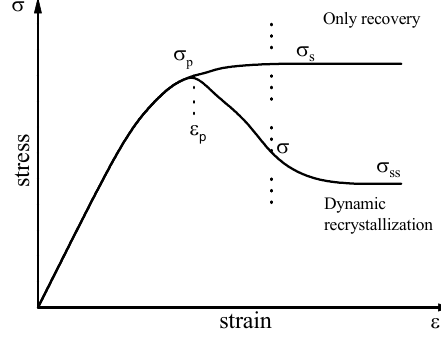
Figure 11. Schematic of stress ‐ strain curves.